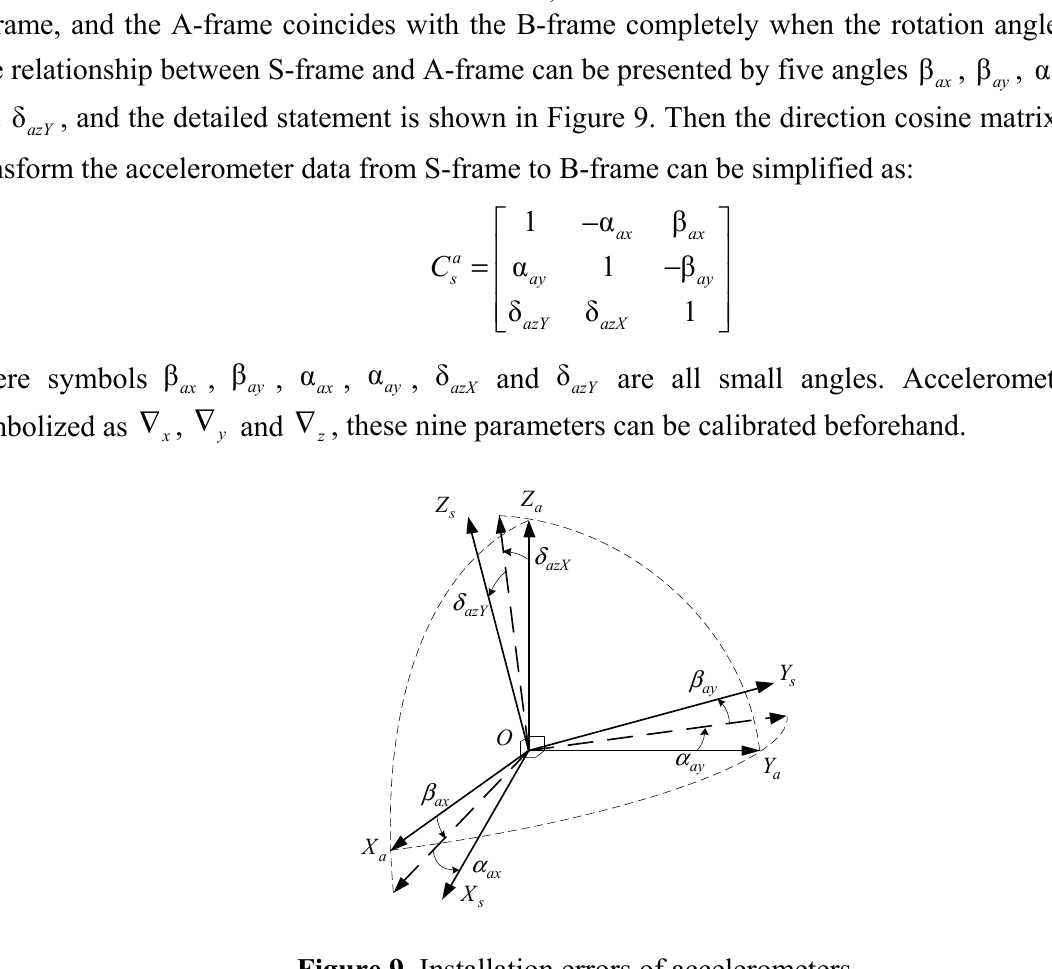
Figure 9. Installation errors of